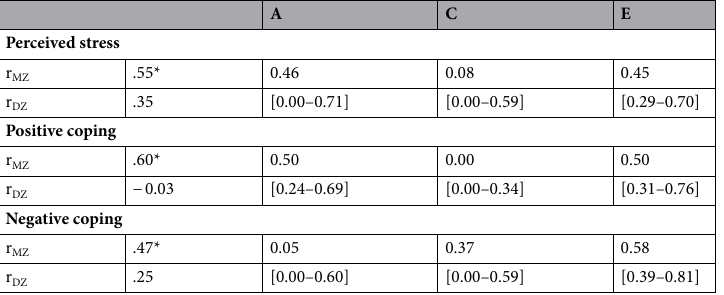
Table 4. Within twin associations and estimations of variation in perceived stress, positive coping and negative coping that is explained by heritability (A), shared environment (C) and unique environment (E). N MZ = 41 N DZ = 21 complete twin pairs. Asterisks indicate significant correlations ( p <